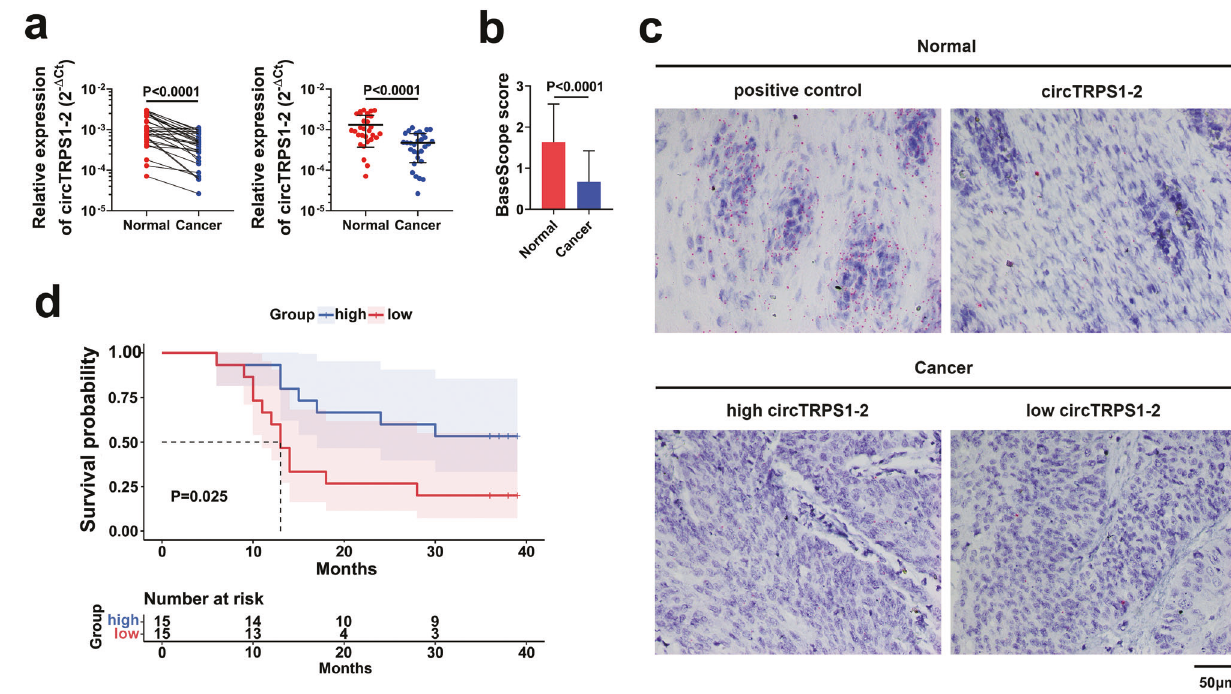
Fig. 3 Downregulation of circTRPS1-2 in ESCC tissues and positive correlation between its expression and prognosis. a Expression of circTRPS1-2 was signi fi cantly lower in ESCC tissues than in adjacent normal tissues. β -actin served as reference genes. Results are from three independent experiments. b The results of BaseScope assay showed that the circTRPS1-2 signals in ESCC tissues were signi fi cantly less than that in adjacent normal tissues. Data are mean ± SD ( n = 30). c Representative images from the BaseScope assay of ESCC tissues and adjacent normal tissues. Cells contained a visible red dot or cluster were considered positive. positive control, human PPIB gene probes; circTRPS1-2, hsa_circ_0085362 probes. Magni fi cation, 400×. Scale bar, 50 µm. d Overall survival time was signi fi cantly longer among patients expressing high circTRPS1-2 than among patients expressing low